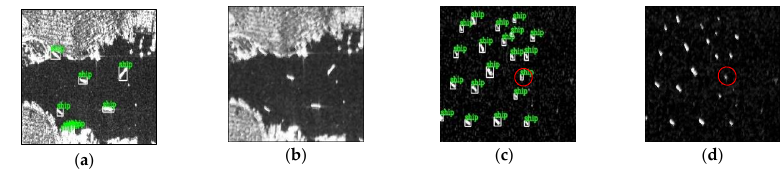
Figure 3. Refined lee filter. ( a , c ) Two original images in the SSDD; ( b , d ) two filtered images in the ESSDD. The ground truth is marked in green and the red circle indicates that the ship may be miss-detected.